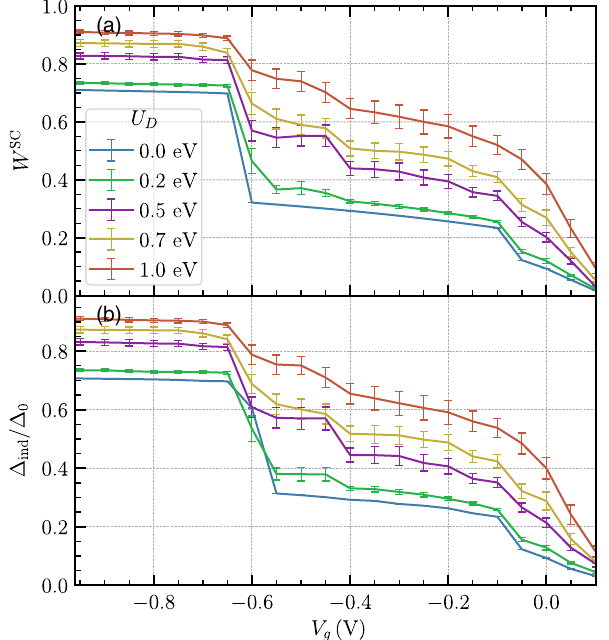
FIG. 15. (a) Weight in the superconductor and (b) induced gap as a function of the gate voltage for a range of disorder 0 – 1 eV averaged over 25 disorder realizations. strengths U D ¼ The presence of disorder increases the induced gap.